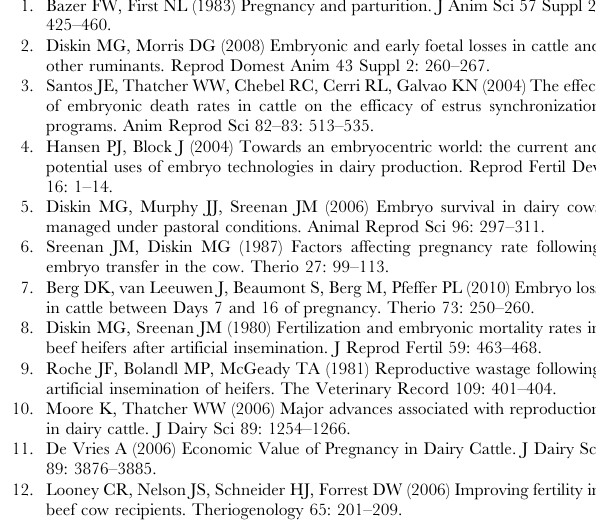
intensity values. Table S1 Analysis of the microarray data with Bioconductor Limma. Table S2 Lists of transcripts clustered in the endometrium. Table S3 qRT-PCR primers of candidate genes and house- keeping genes. Table S4 Selected overrepresented functional categories for differentially expressed genes in High Fertile as compared to Infertile heifers (nominal P-value , 0.01). Table S5 Selected overrepresented functional categories for differentially expressed genes in High Fertile as compared to Subfertile heifers (nominal P-value ,